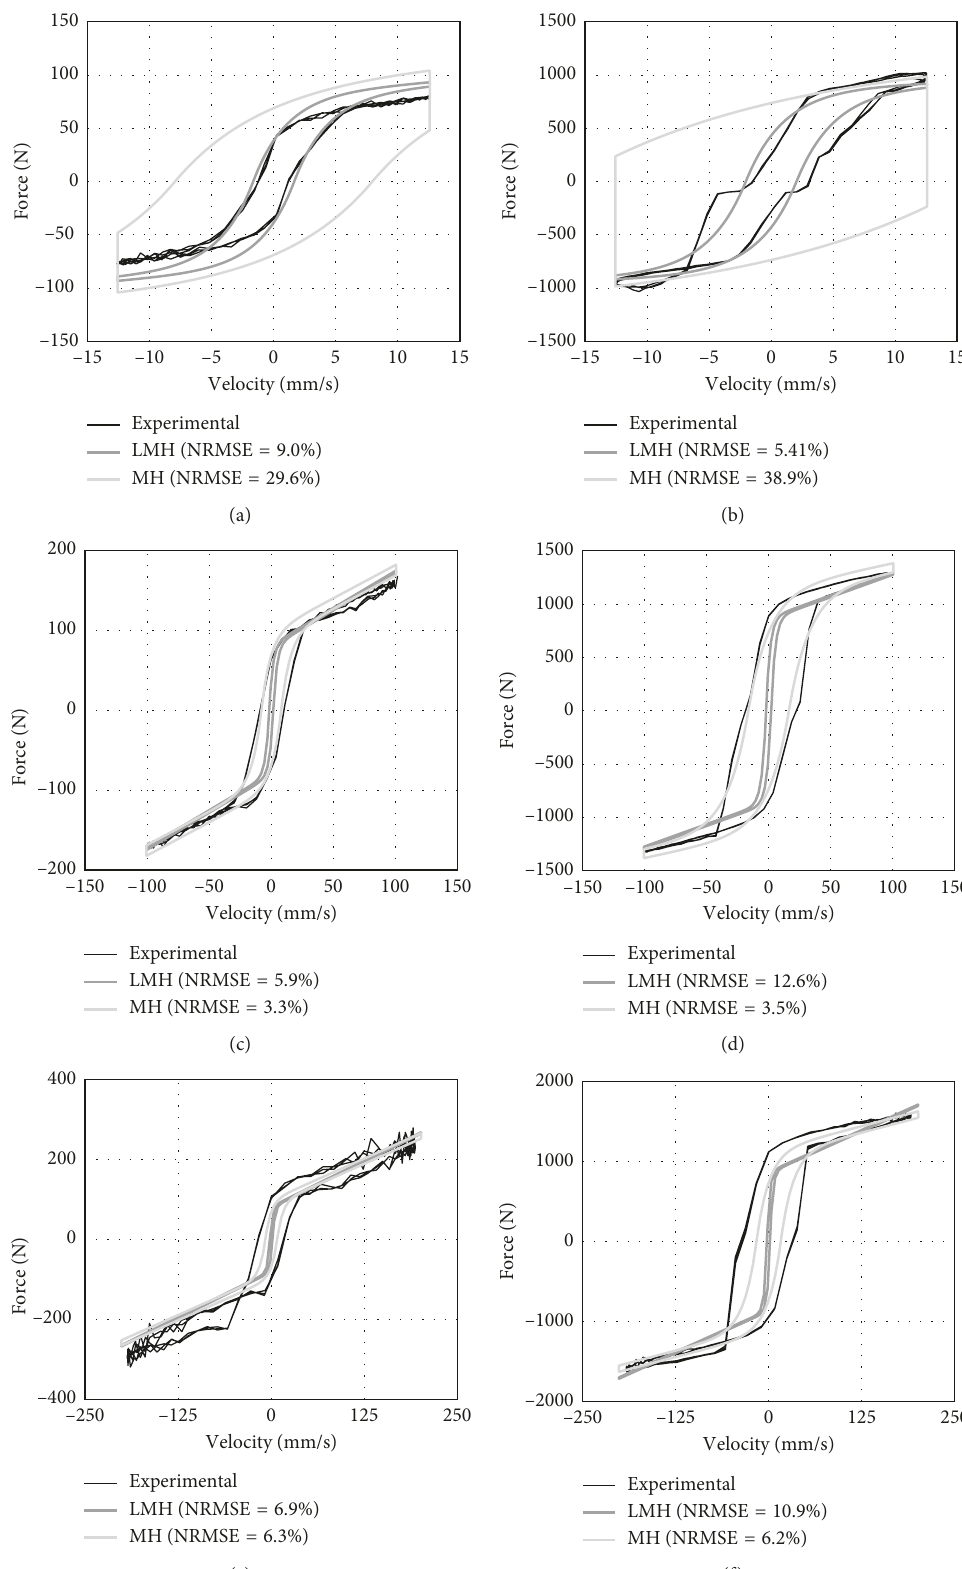
Figure 12: Hysteretic regularised Bingham model (fitted with LMH and MH tests) predictions for six different tests: (a) low velocity without intensity; (b) low velocity with I 1A; (c) medium velocity without intensity; (d) medium velocity with I (cid:31) intensity; (f) high velocity with I (cid:31)